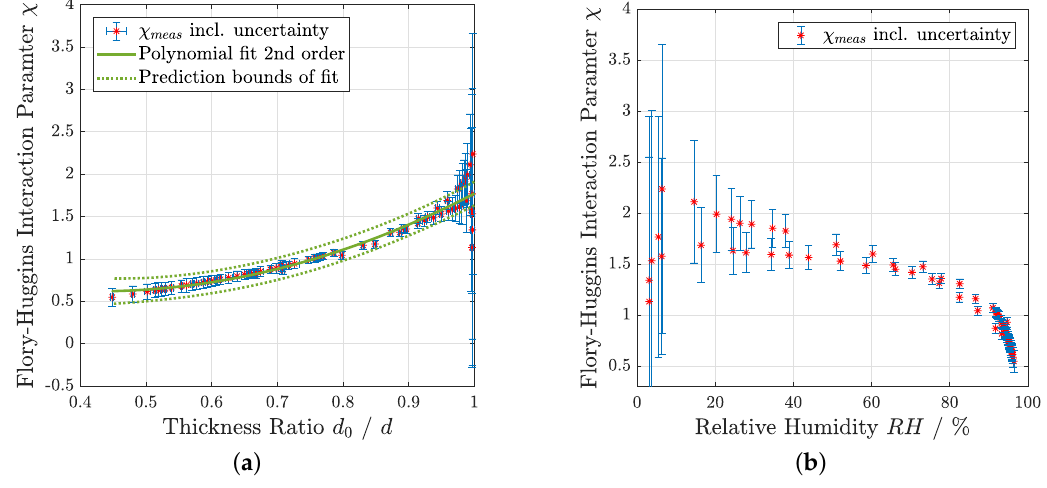
Figure 4. Flory–Huggins interaction parameter χ derived by humidity and thickness measurements as a function of the hydrogel thickness ratio d 0 / d with corresponding model fit in ( a ) and as a function of the applied relative humidity RH in ( b ). Result for the fit parameters: χ 0 = 1.6 ± 0.4, χ 1 = − 4.0 ± 1.0, and χ 2 = 4.2 ±